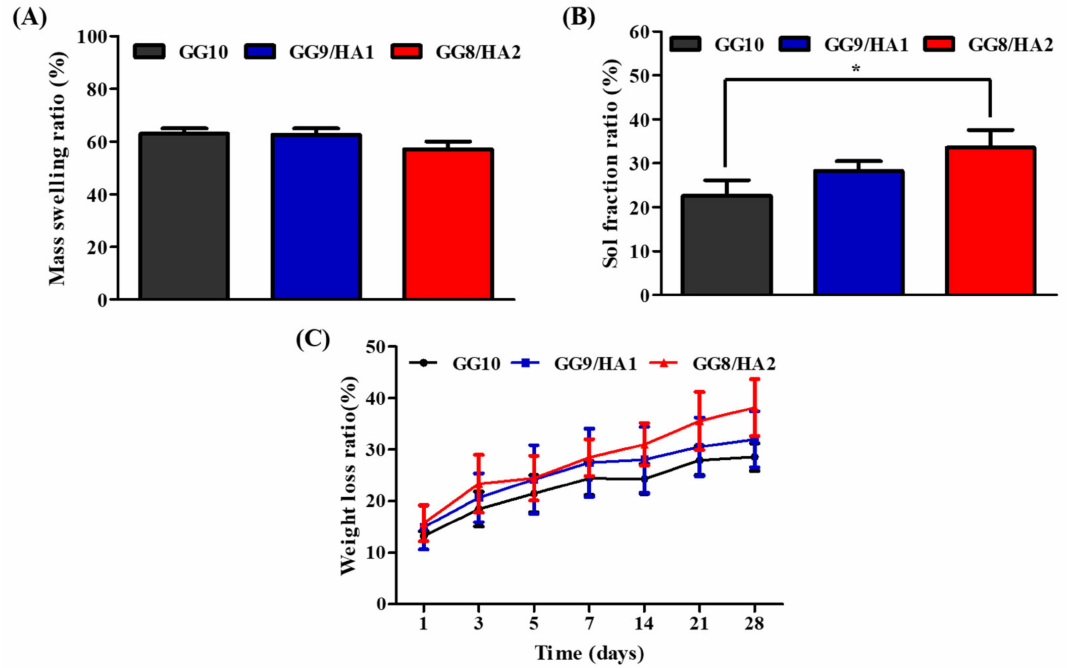
Figure 1. Physicochemical analysis of the hydrogels: ( A ) mass swelling ratio (%), ( B ) sol fraction ratio (%), and ( C ) weight loss ratio (%), analyzed for 28 days (values are means ± SD, n = 4, p < 0.05